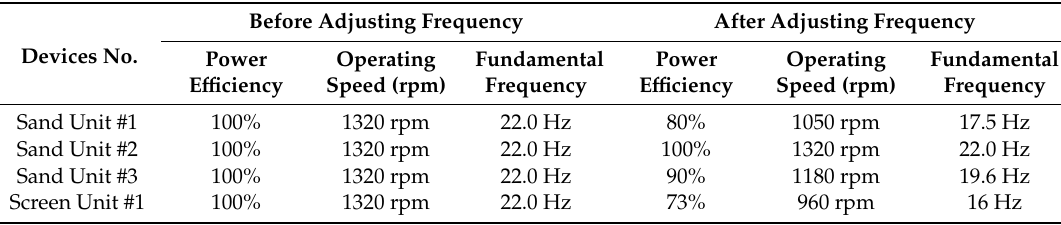
Table 1. Comparison of driving (excitation) frequencies of the sand unit and screen unit.